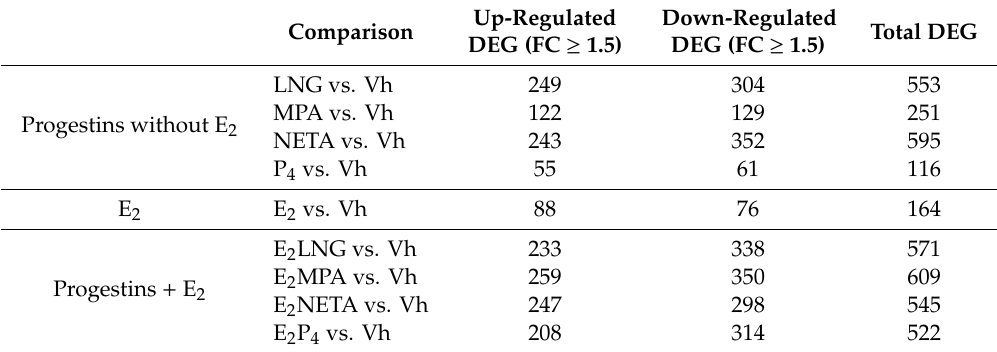
Up-Regulated Down-Regulated Comparison Total DEG DEG (FC ≥ 1.5) DEG (FC ≥ 1.5) LNG vs.